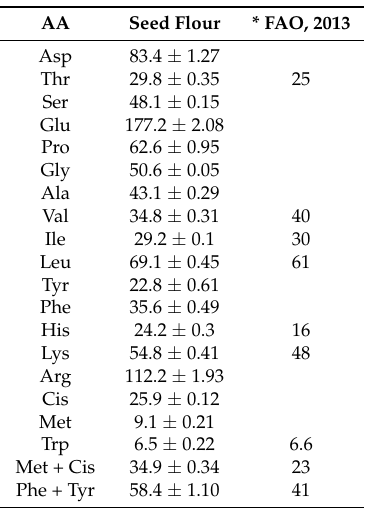
Table 2. Amino acid (AA) profile of mesquite seed flour (mg/g protein).